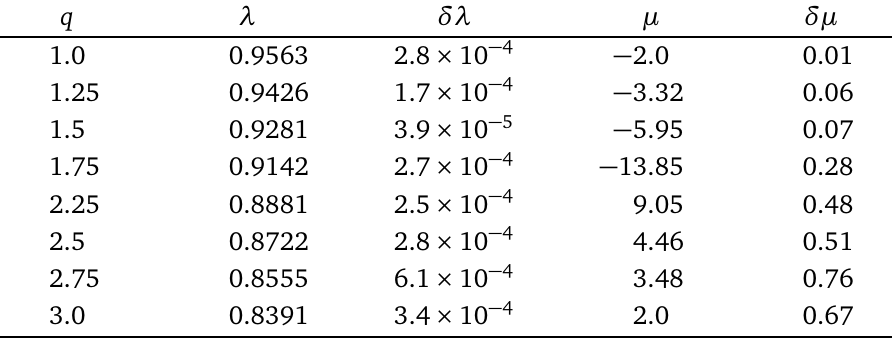
Table 6: Values of the coefficients λ and µ , together with the estimated errors, as functions of q